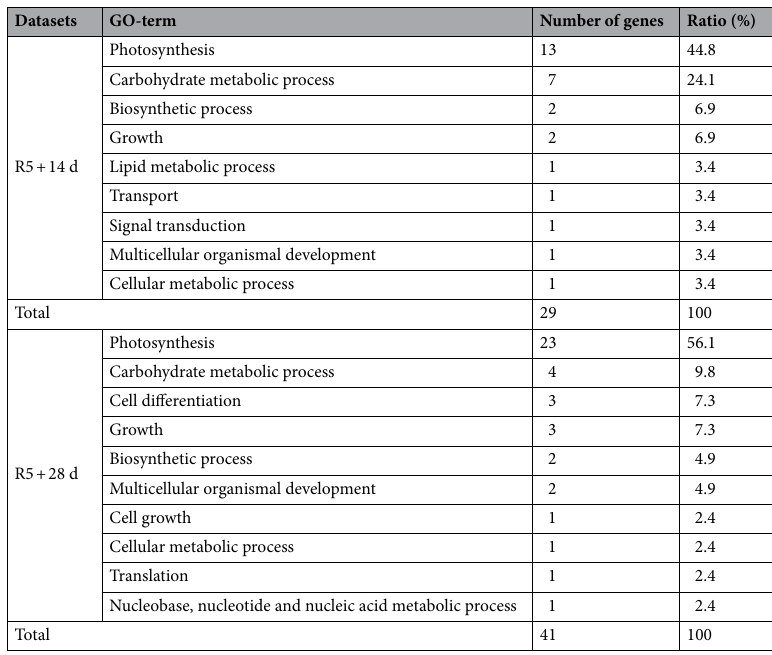
Table 5. GO enrichment analysis of significantly upregulated or downregulated genes in plants exposed to the thinning treatment at the R5 growth stage. Gene ontology (GO) enrichment analysis was conducted at the web service of SoyBase (https:// www. soyba se. org/) with annotations from the Wm82.a2. v1 (Glyma